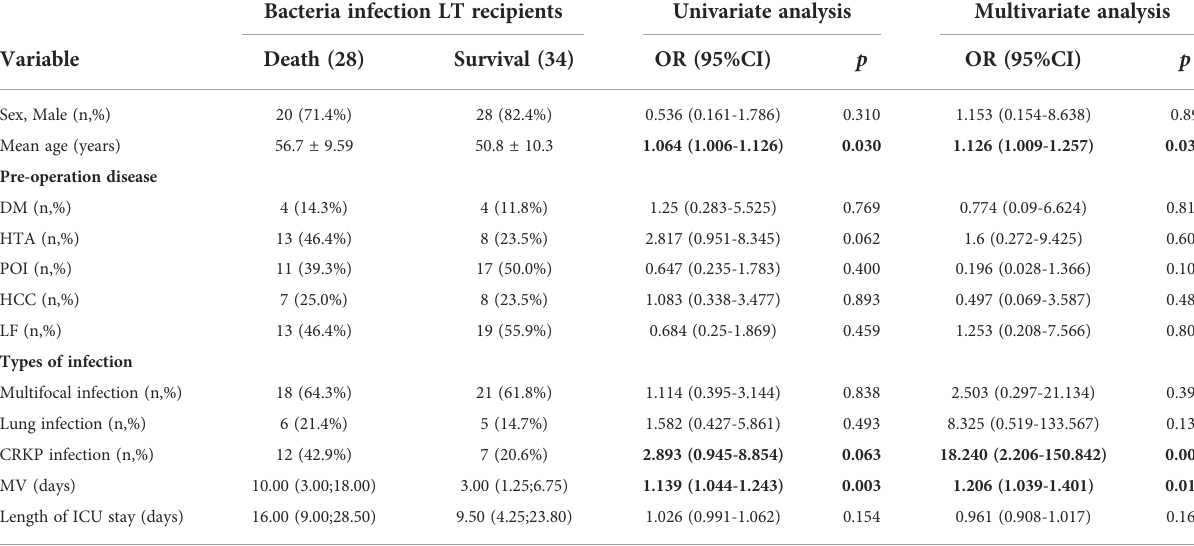
TABLE 5 Univariate and multivariate analysis of risk factors for 3-months mortality in liver transplant recipients with early bacteria infection. Bacteria infection LT